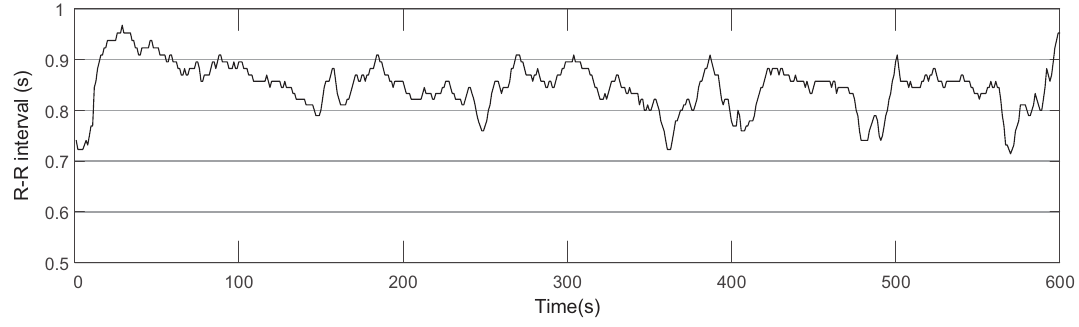
Figure 4. R-R intervals calculated based on the ECG signal which is collected from one subject during the 1-back task. All of the R-R intervals are longer than 0.5